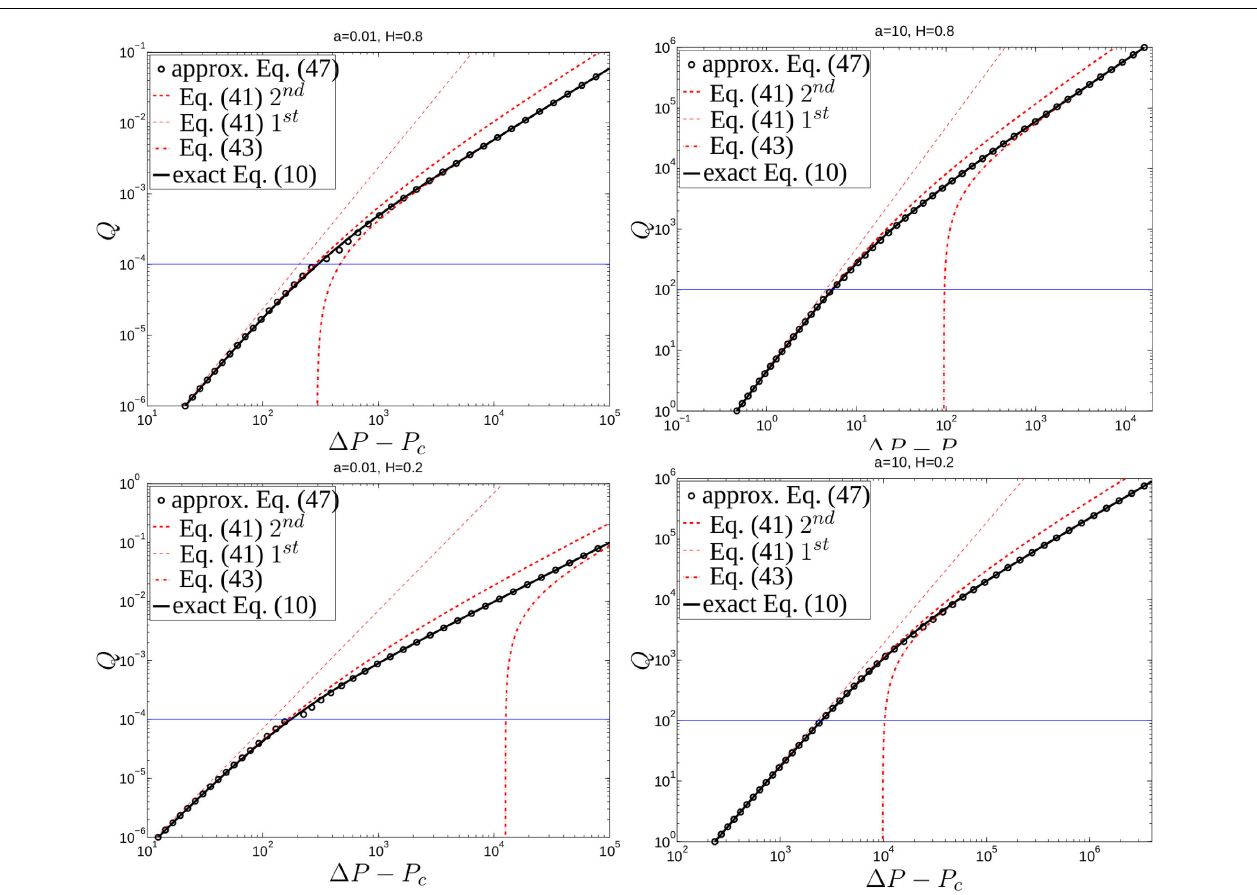
FIGURE 3 | Flow rate Q as function of the applied pressure drop (cid:2) P − P c for different Hurst coefficient H and different openings a . The other parameters are D = 1 / 12, σ c = 1, L = 2 19 . Black plain line represent numerical integration of the exact expression of Equation (12). Dashed lines represents the asymptotic regimes for Q (cid:12) 1 defined by Equation (44) (thick line: second order for thin line for first order) and for Q (cid:13) 1 defined by